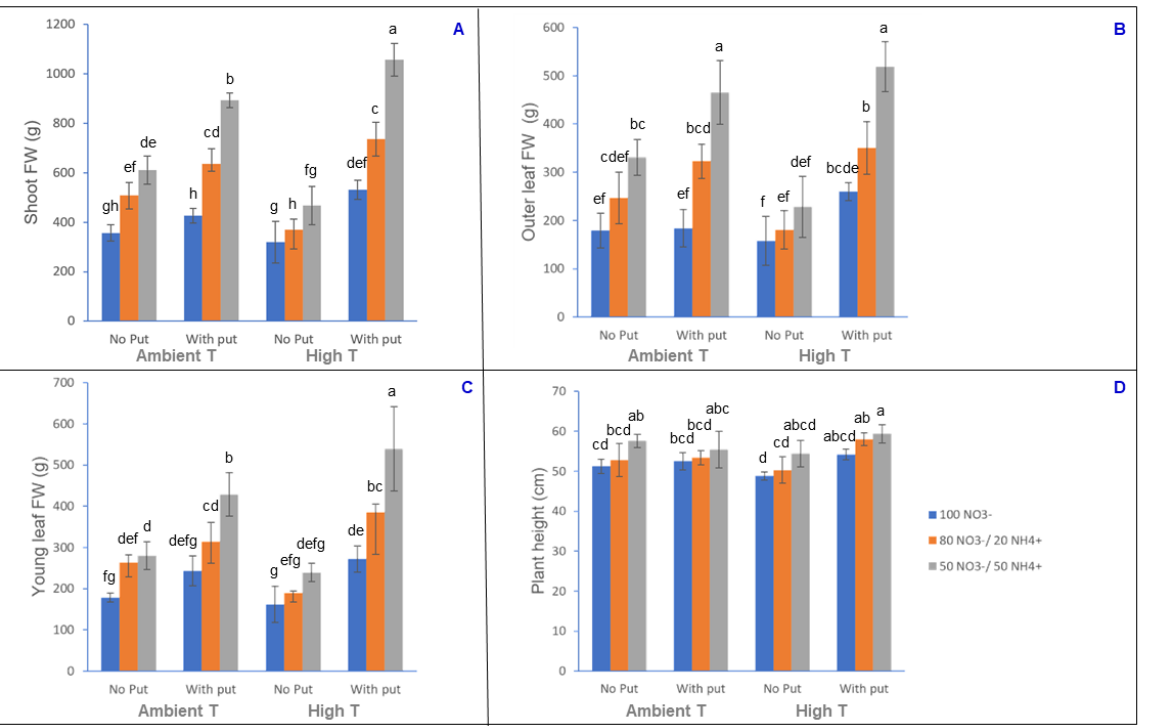
Figure 1. Effect of heat stress, different NO 3 − /NH 4+ ratios and the foliar application of 2.5 mM putrescine on shoot FW ( A ), outer leaf FW ( B ), young leaf FW ( C ), and plant height ( D ) of cauliflower. For data analysis, an ANOVA was performed and the pairwise changes were defined using the Tukey post hoc test. Thus, different letters represent significantly different mean values according to the Tukey test at p ≤ 0.05.